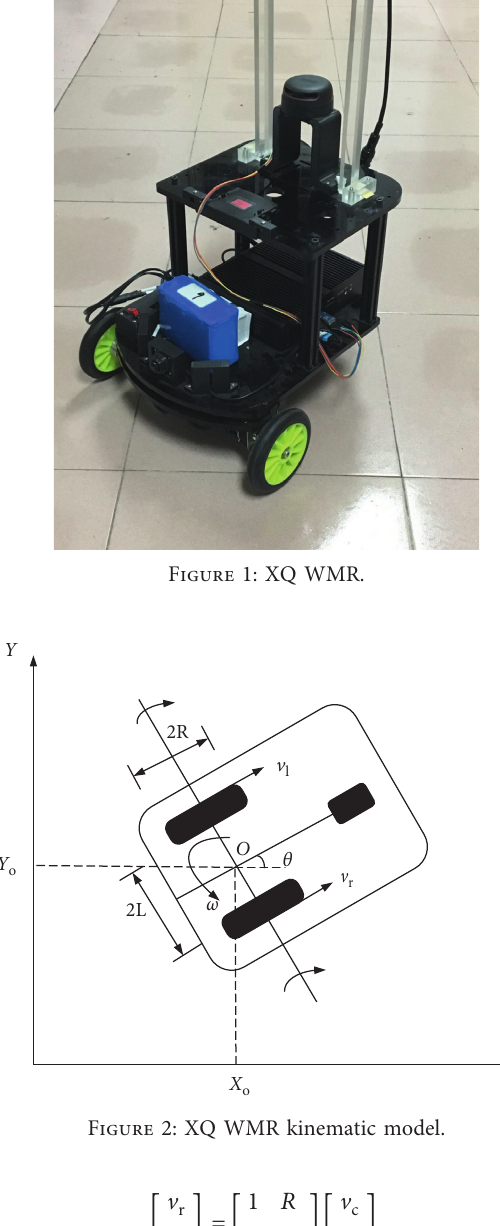
Figure 2: XQ WMR kinematic